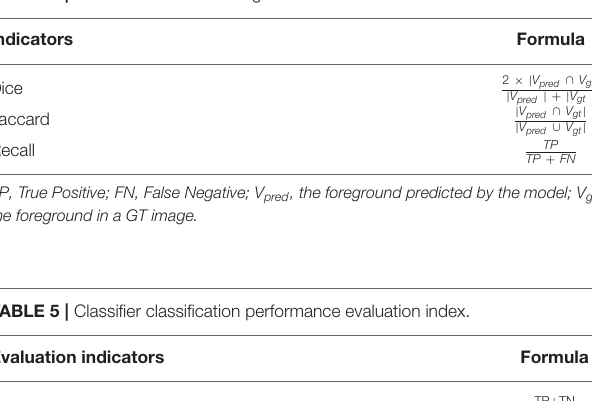
TABLE 3 | Deep learning model parameters.